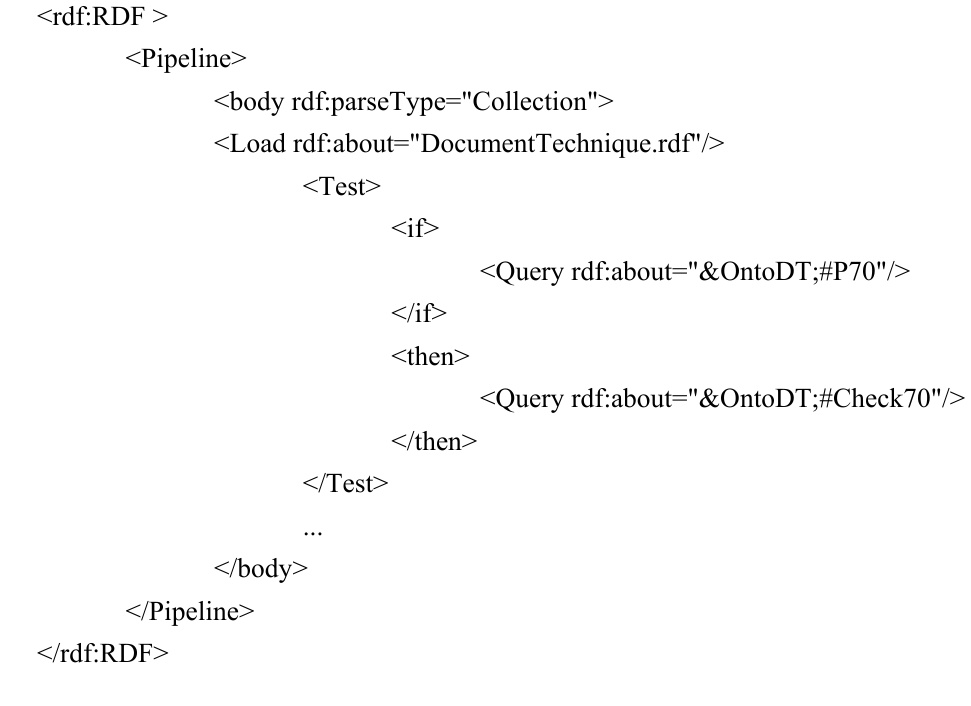
Figure 10. Extract of the RDF representation of a verification process